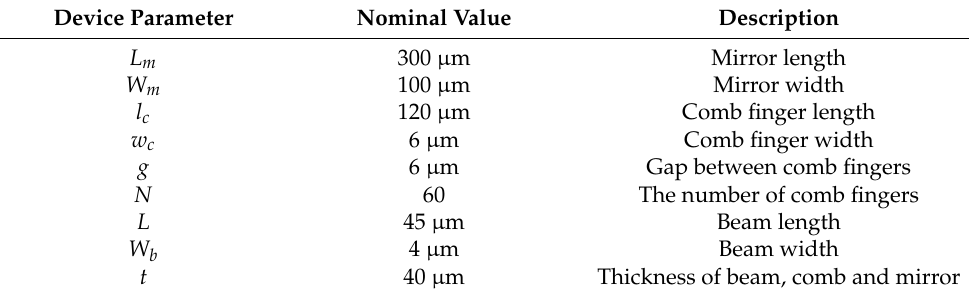
Table 1. Design parameters for the comb-drive device. Device